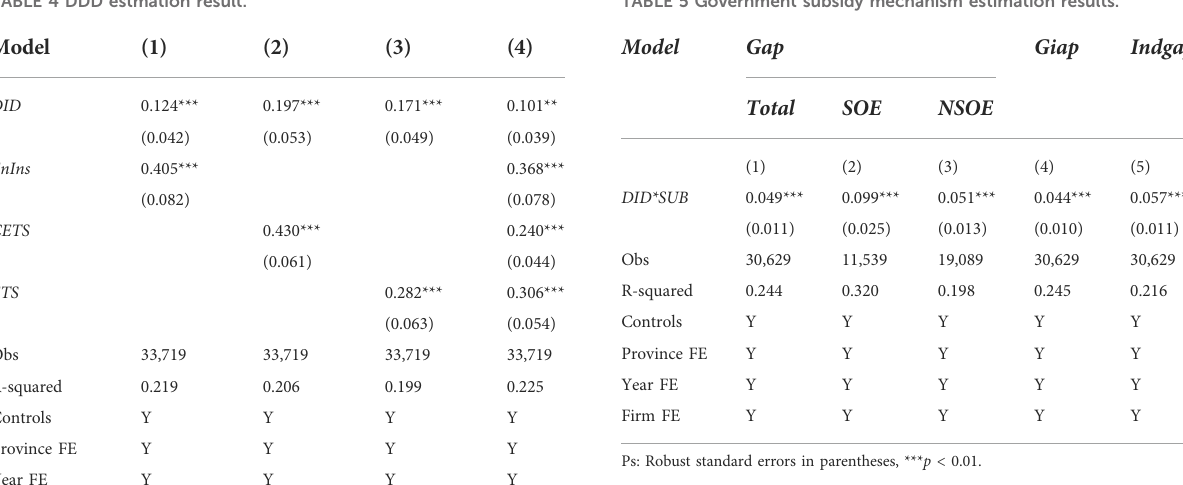
TABLE 5 Government subsidy mechanism estimation